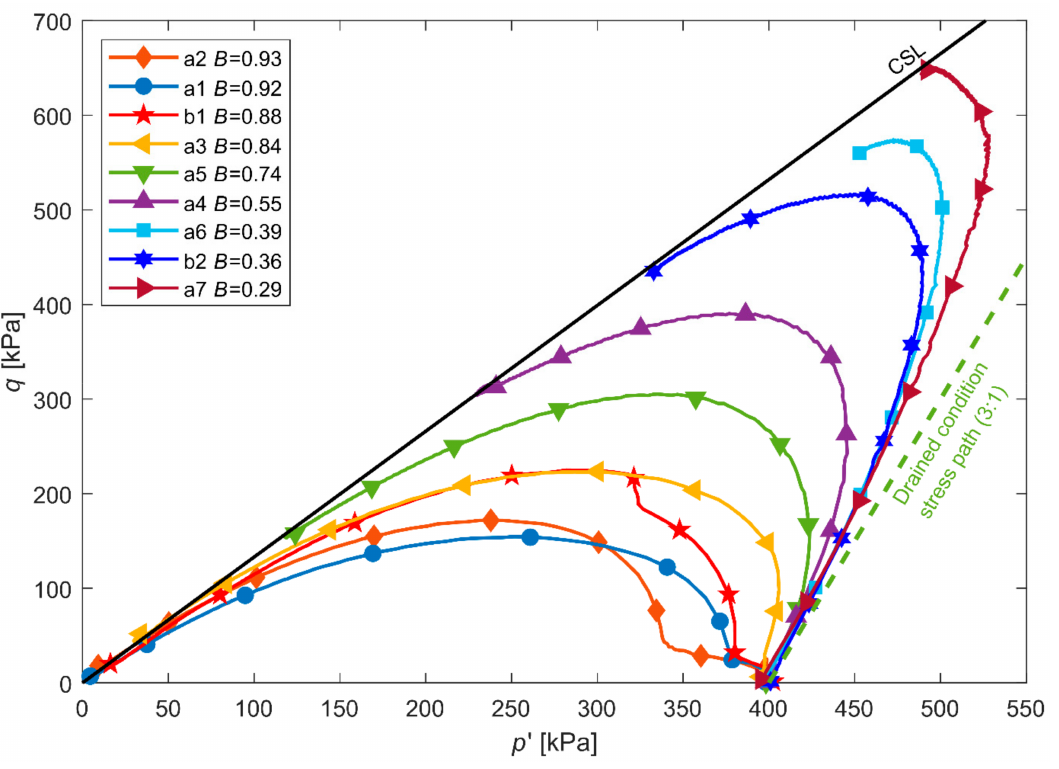
Figure 13. Stress paths corresponding to the behaviour of OZM50 tailings at different levels of saturation.